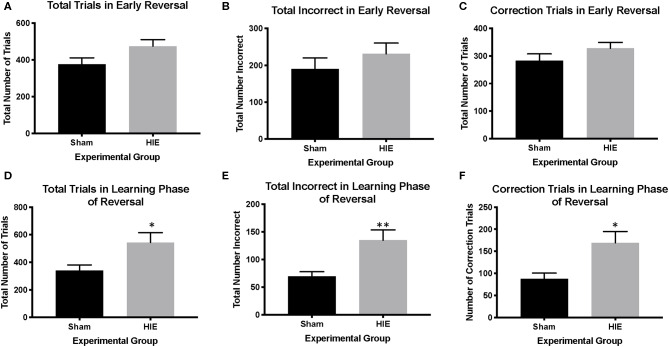
HIE yields distinct early phase and learning phase reversal deficits. In the early phase of reversal, there were no significant differences between HIE and sham in the total trials completed, the total incorrect, and the number of correction trials (A–C). However, in the learning phase of reversal, the HIE group had significantly more total trials (D), more incorrect trials (E) and more correction trials (F) compared to sham (n = 13–15, *p < 0.05, **p < 0.01). Data is represented as mean ± standard error of the mean (SEM).